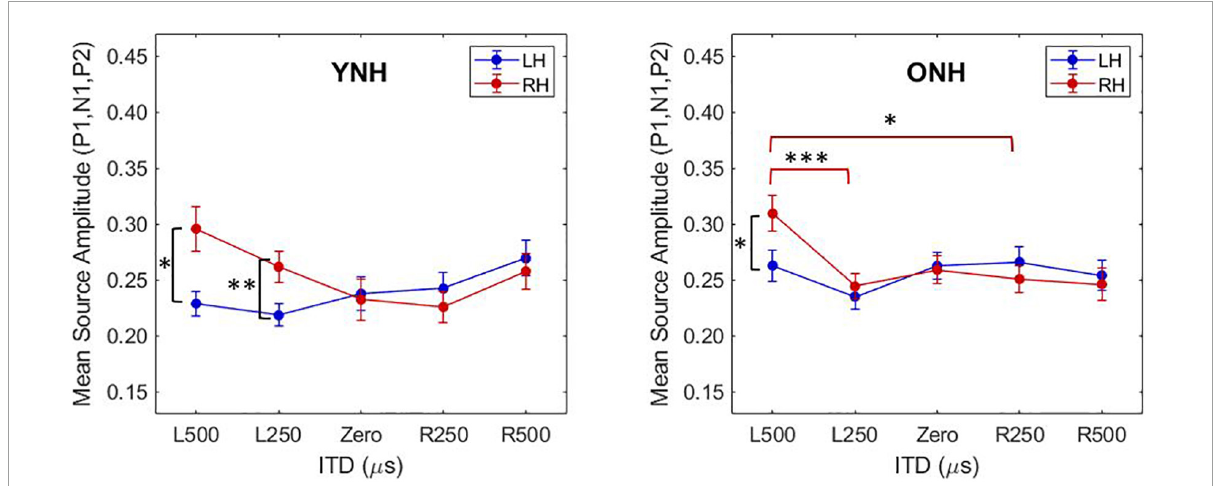
FIGURE6 Mean source amplitudes averaged across absolute values of peak components (P1, N1, P2) in each hemisphere for each interaural time difference (ITD) condition and listener group (YNH, left panel ; ONH, right panel ). Significant differences between hemispheres were observed for both YNH (L500, L250) and ONH (L500) groups, and between conditions within right hemisphere only for ONH. Asterisks indicate significance levels: ∗ p < 0.05, ∗∗ p < 0.01, ∗∗∗ p < 0.001 .